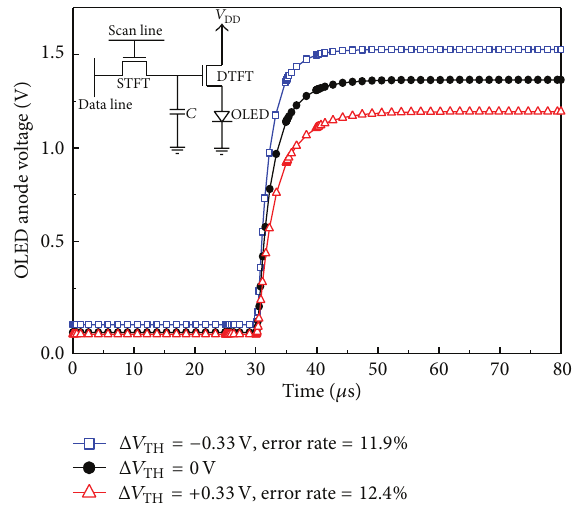
Figure 1: Anode voltages of OLEDs at various DTFT threshold = −0.33, 0, and + 0.33 𝑉) for the conventional voltage shifts (Δ𝑉 TH = 3 two-TFT driving scheme when 𝑉 DATA